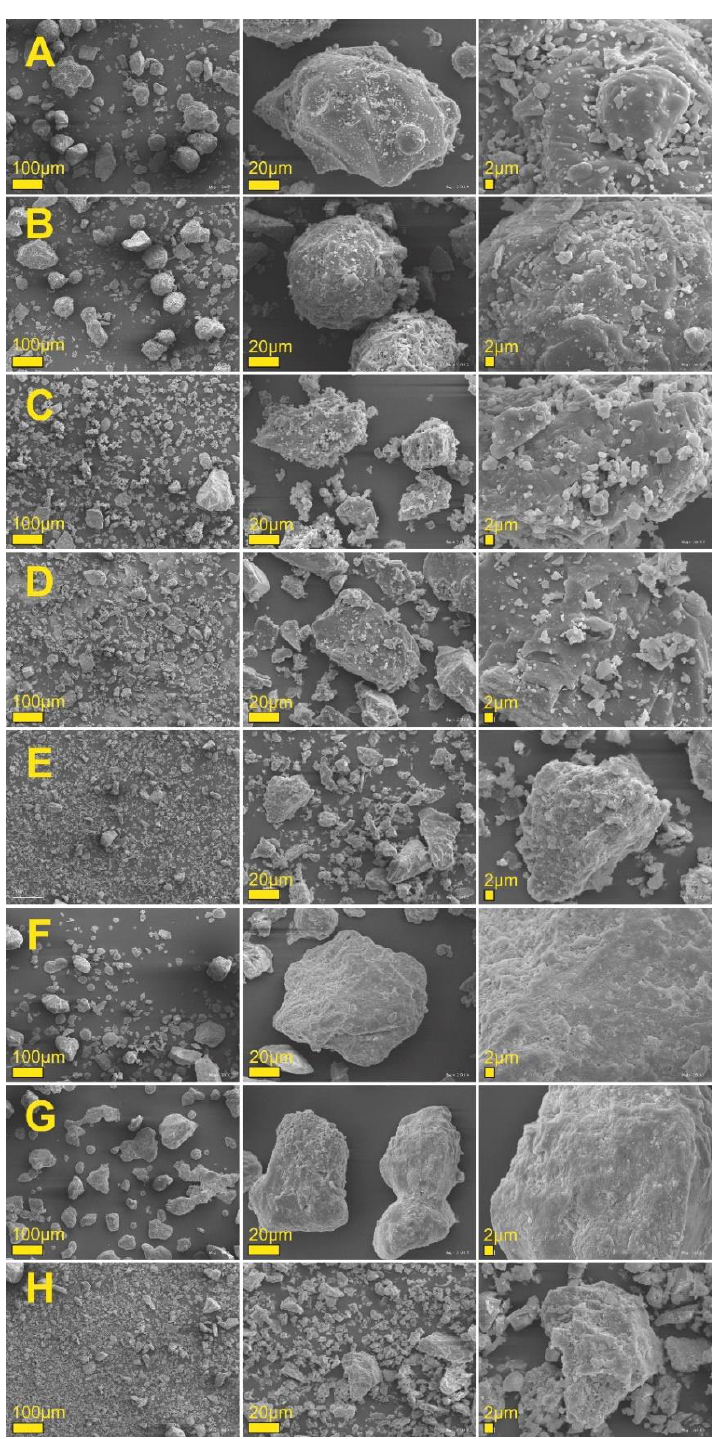
Figure 1. SEM images of the studied calcium matrices. ( A ) EGR, ( B ) EHSI, ( C ) ELI, ( D ) ELA, ( E ) ED, ( F ) ECM, ( G ) EK, ( H ) EC.